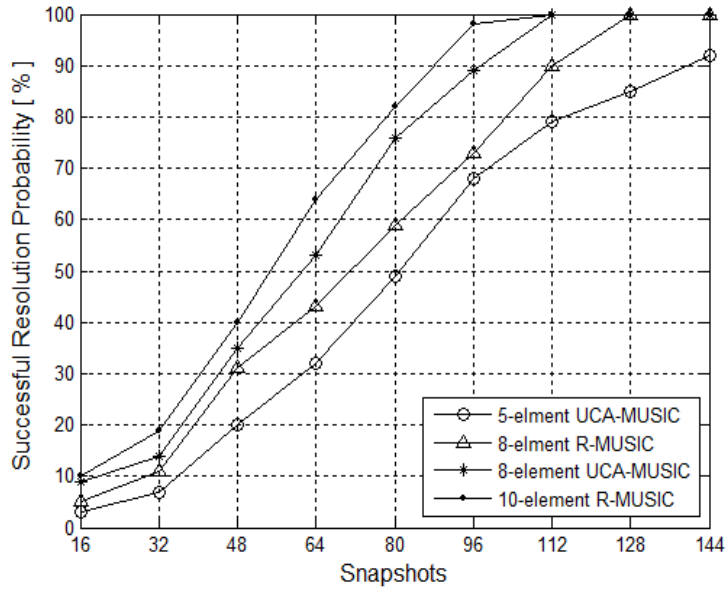
Figure 5. Successful resolution probability versus snapshots